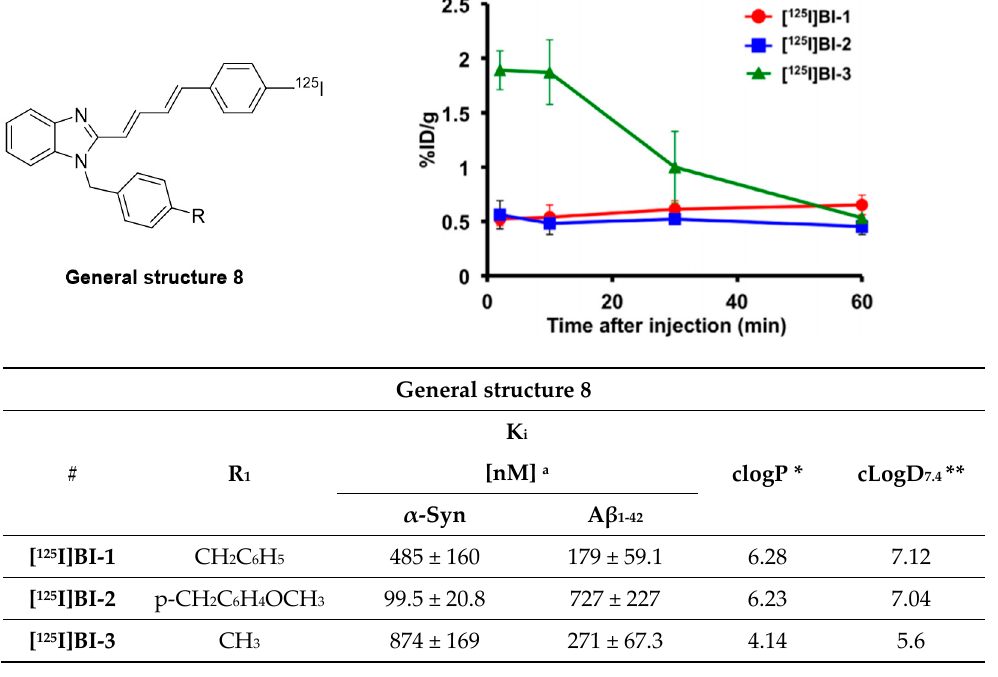
Figure 17. General structure of radio-iodinated benzoimidazole derivatives and their brain uptake after intravenous injection. Binding affinities were determined on recombinant α -syn and A β 1–42 aggregates. (Reprinted with permission from [117]. Copyright 2017 Elsevier). * clogP values were calculated by BioByte. ** clogD 7.4 values calculated by ACD/Percepta.